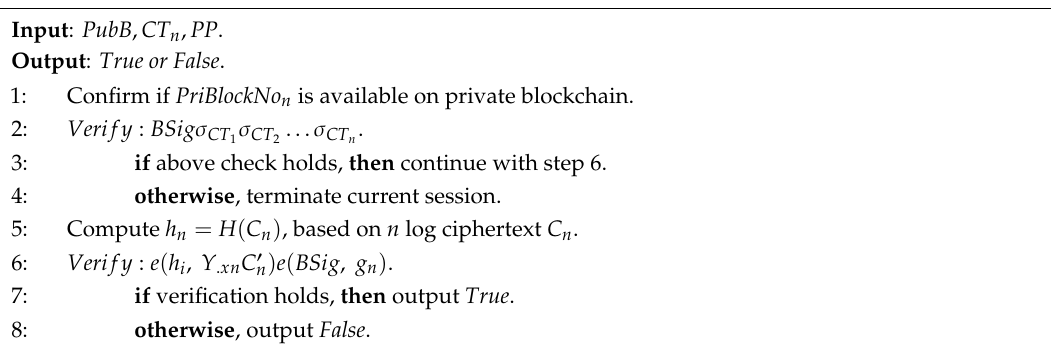
Algorithm 13: Public block